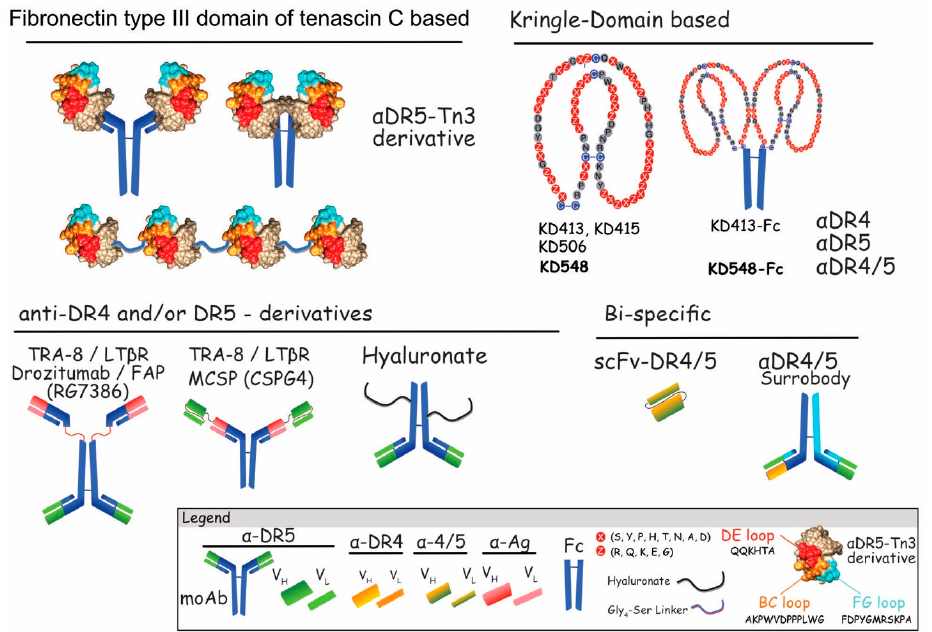
Figure 8. Schematic representation of unconventional and BsAbs harboring selectivity for DR4 and/or DR5. Fibronectin type III domain of tenascin C-based formats recognizing DR5, are presented in the upper left, covalently linked to Igs, Fc or as single-chains. Amino acids highlighted in red/orange and pale blue correspond to TN3 variable loops (DE, FG and BC) which can be mutated without changing its globular structure. These correspond to aa that allow binding to DR5. Amino acids shown in beige, depict TN3 amino acids that need to be preserved to maintain the globular structure of the recombinant protein. Upper right panel illustrates Kringle domain (KD)-based formats fused to the Fc. Specific KDs are numbered 413 to 548. Affinity binding for DR4 and/or DR5 is indicated. Lower left panel depicts anti-DR4 and/or DR5–derivatives targeting TRA-8, LT β R, FAP, MCSP, or hyaluronate. BsAbs targeting both DR4 and DR5 are represented in the lower right.